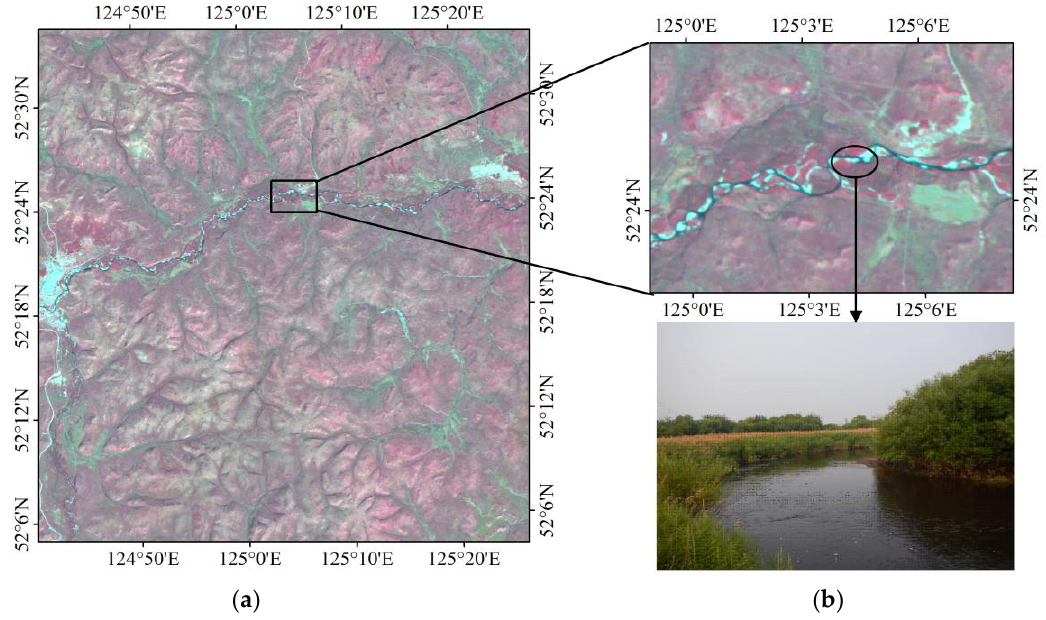
Figure 11. False color image of HJ-1 and a field photo collected from the Daxing’an Mountains. ( a ) Daxing’an Mountains; ( b ) rivers and wetlands.